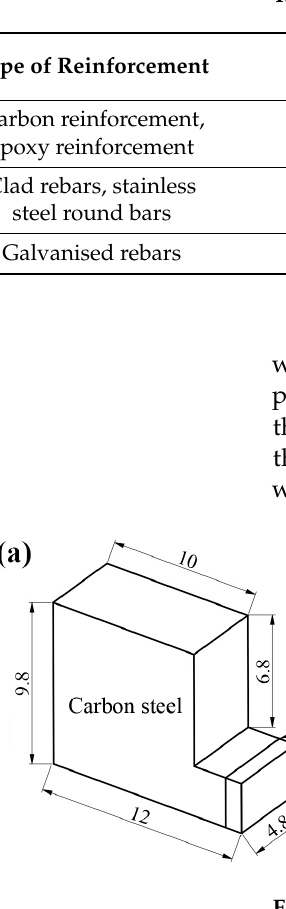
Figure 7. Schematic of the shear jig: ( a ) Profile of the bond-strength test specimen; ( b ) schematic of the shear jig operation; ( c ) schematic of the bonding strength test.